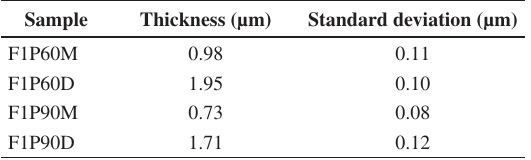
Table 2. Layer thicknesses for the hybrid